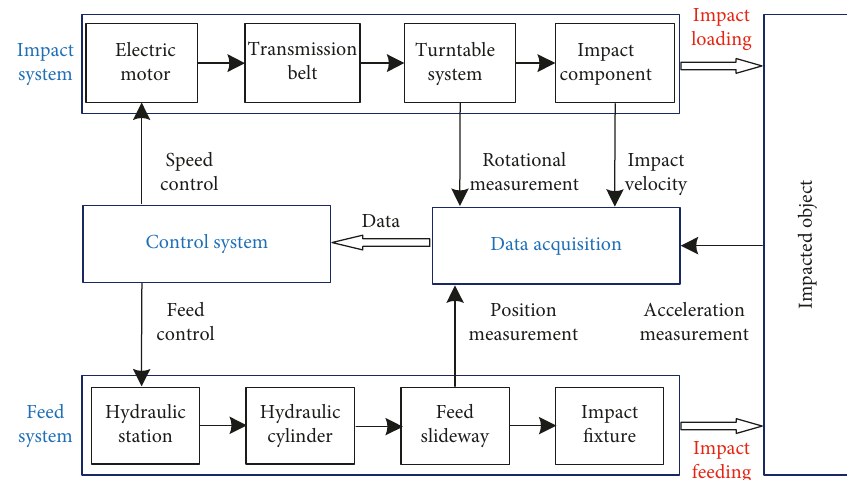
Figure 3: Block diagram of the multiple impact equipment.